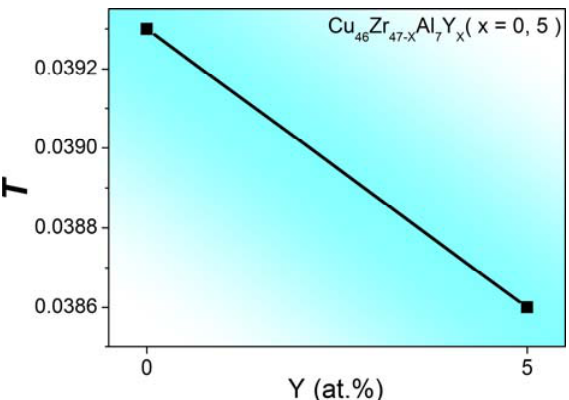
Figure 6. Variance of the edge lengths ( T ) of all the tetrahedra forming VCs in Cu 46 Zr 42 Al 7 Y 5 and Cu 46 Zr 47 Al 7 . This value determines the regularity of VCs.